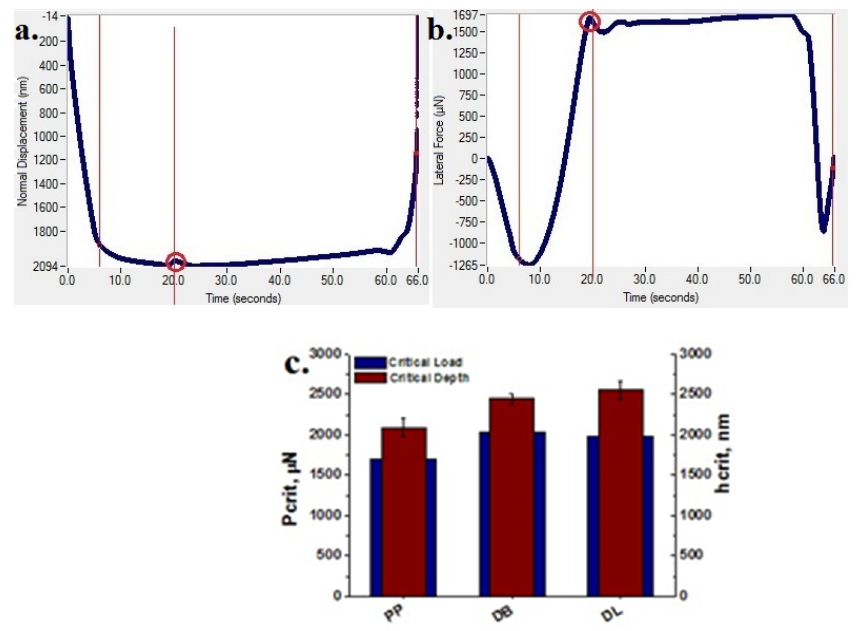
Figure 14. Representative plots of normal displacement ( a ) and lateral force ( b ) versus time from a 5000 µN ramping force nanoscratch test on PP. Critical events in the data (showing point of distinct material piled up) are circled and correspond to hcrit and Pcrit; Pcrit and hcrit data from 5000 µN ramping force nanoscratch tests on PP and PP hybrid composites ( c ).